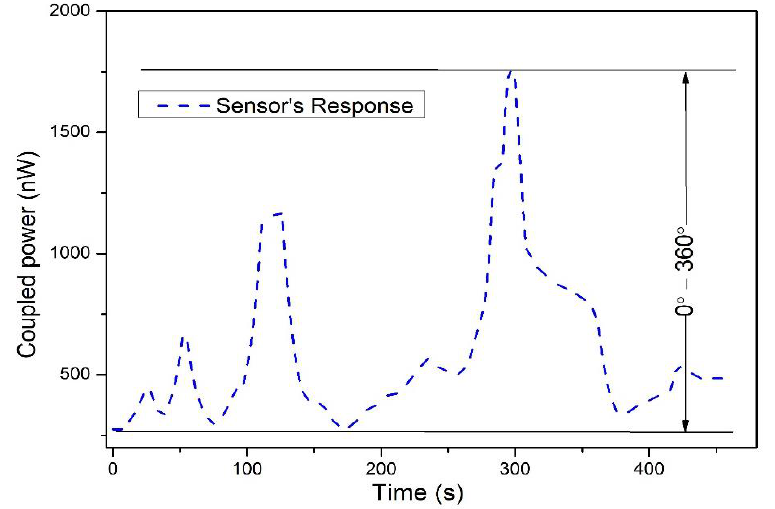
Figure 9. Sensor response to randomly operated rotational motion over time.